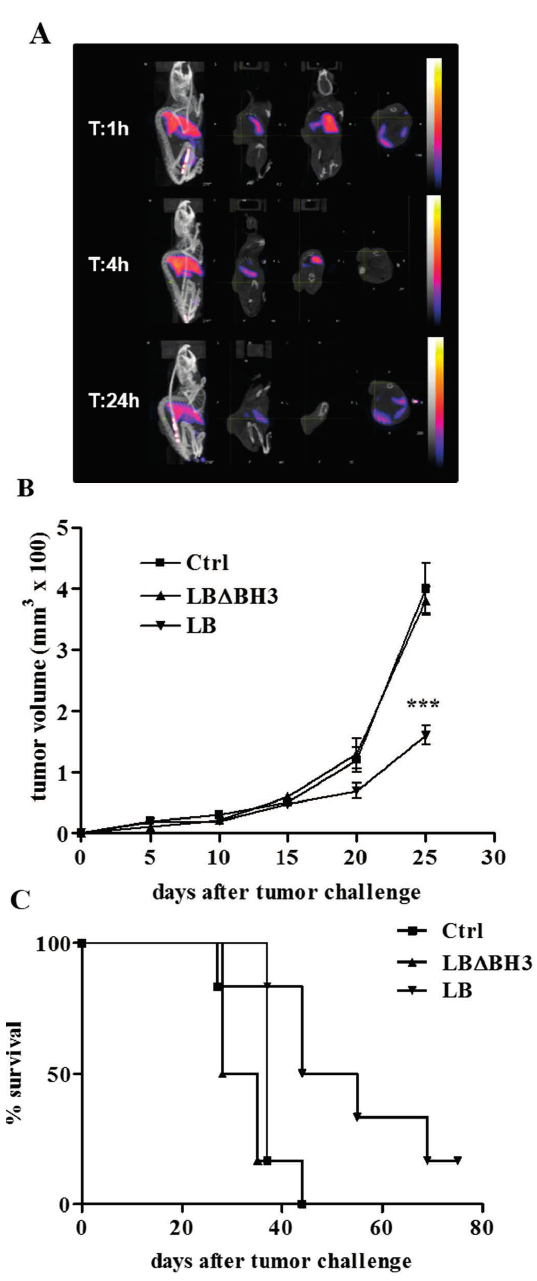
Figure 4. Intravenous treatment with LB in GL26-bearing mice. ( A ) SPECT/CT images at 1, 4 and 24 h after treatment with a single intravenous injection of 99m Tc-LB; ( B ) GL26 tumor growth over time. *** p < 0.001, LB vs. Ctrl and LB Δ BH3; ( C ) Survival curves, p < 0.05, LB vs. Ctrl and LB Δ